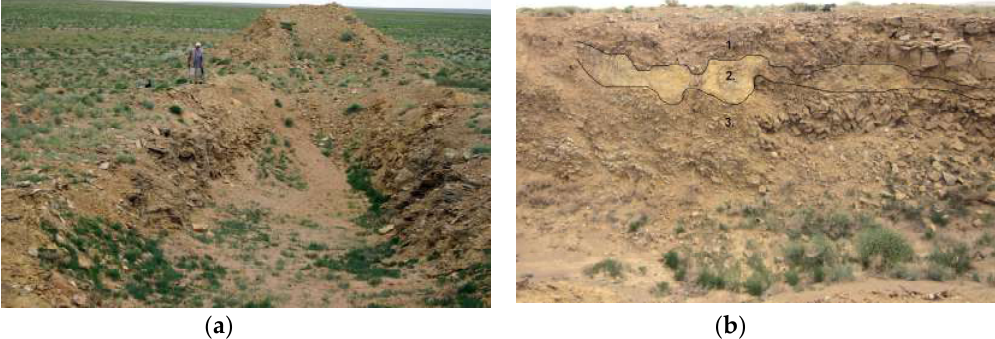
Figure 8. ( a ) Old Russian trench (dug in 1980). General overview. Conglomerate and sandstone trending to SE; ( b ) Historic exploration trench, the picture is of NE wall of the trench, length of the section marked with a black line is approximately 6 m. 1. Dark gray sandstone, 2. Conglomerate and coarse-grained sandstone bearing phosphate, measured with RS125 spectrometer: U—93 ppm, Th—75 ppm, K—0.8%, radioactivity was 720 cps and 3. Gray phosphatic sandstone.